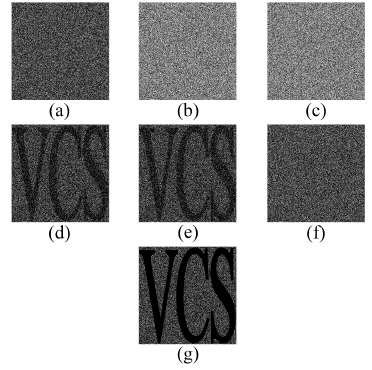
Figure 6. The experiment of the proposed (1, 2, 3)-EVCS. ( a ) essential shadow; ( b,c ) two non-essential shadows; ( d ) revealed image by shadow 1 and 2; ( e ) revealed image by shadow 1 and 3; ( f ) revealed image by shadow 2 and 3; ( g ) revealed image by all three shadows.